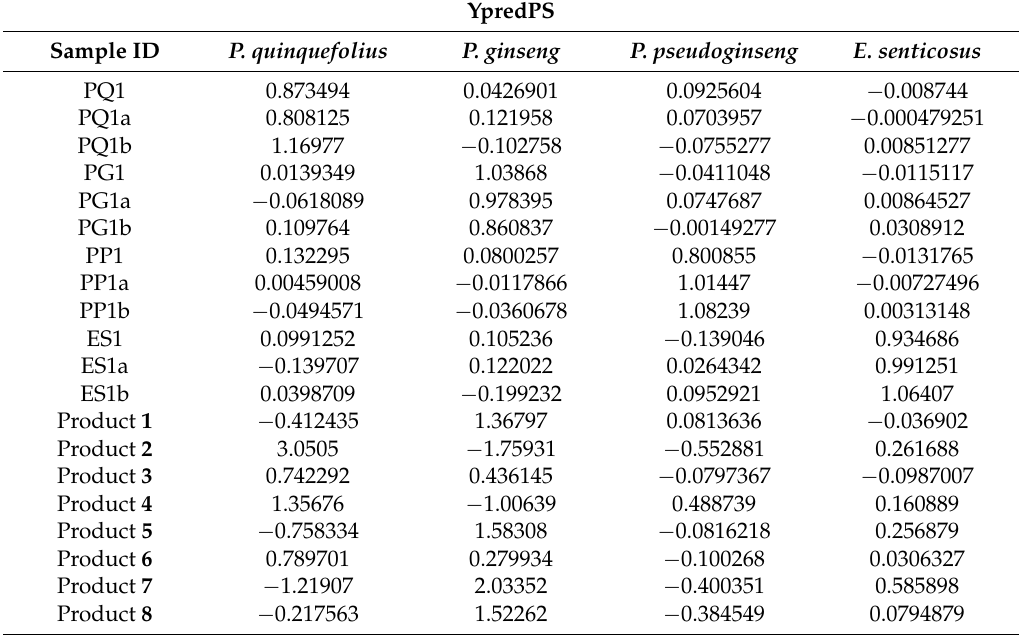
Table 2. Classification list showing predicted Y -values (YPredPS) for both the work set (reference materials) and prediction set (commercial products) based on the OPLS-DA model developed using MIR